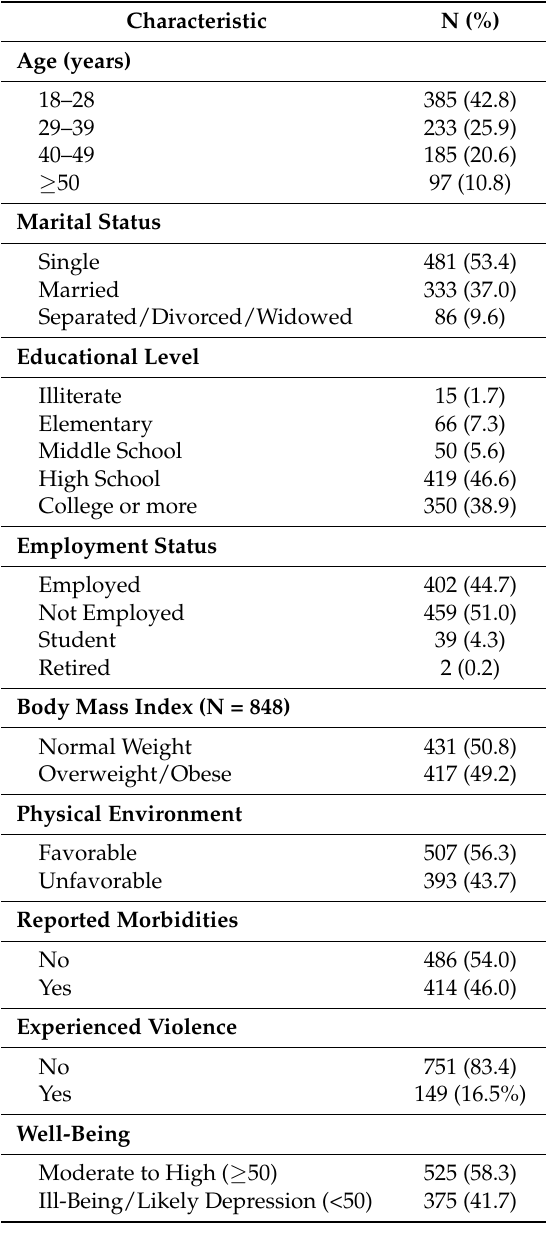
Table 1. Characteristics of study participants (N =